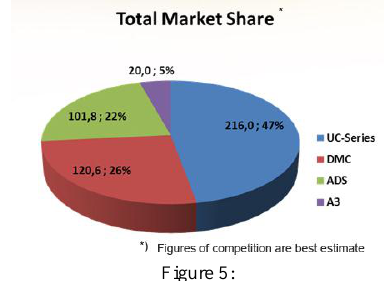
Figure 5: 2011 market share by aerial camera manufacturer